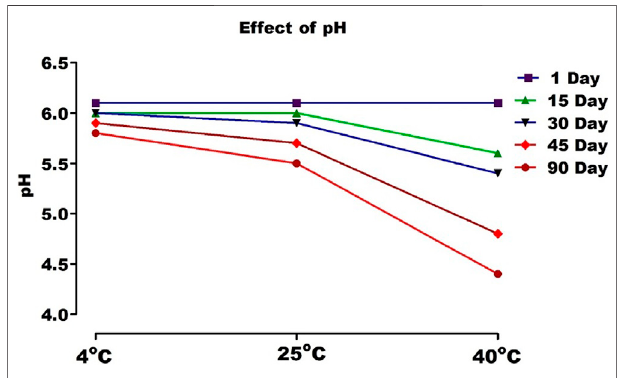
FIGURE 10 | pH of topical gel containing AM extract at different temperature.